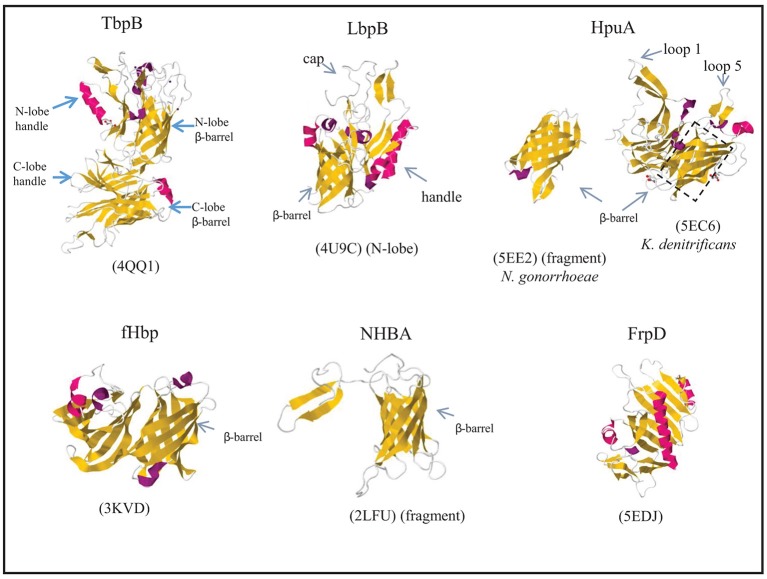
Structures of surface-exposed lipoproteins in N. meningitidis. Where indicated, the structure of only a fragment of the complete protein is available. The structure of N. meningitidis HpuA has not been solved; instead, those of K. denitrificans HpuA and a C-terminal fragment of N. gonorrhoeae HpuA are shown. β-Strands and α-helices are colored yellow and red, respectively, and relevant domains of each protein are indicated. The PDB access codes are given in brackets and references are provided in the text.